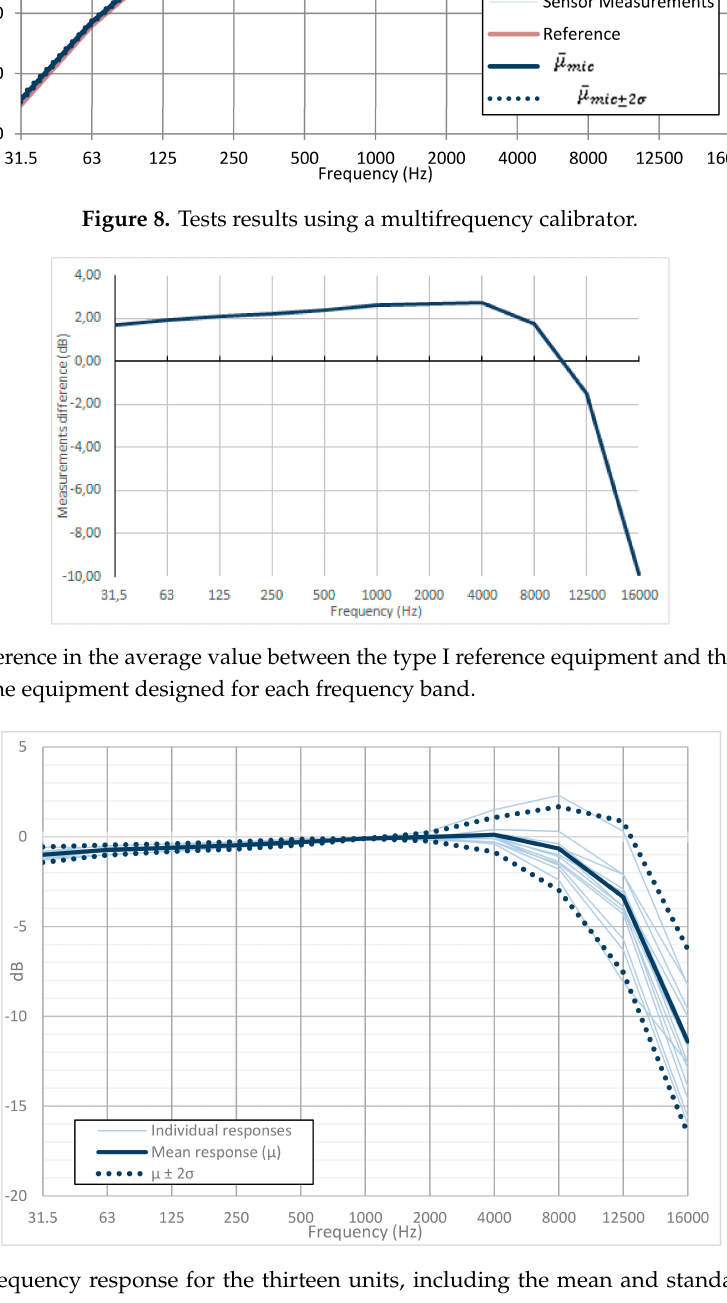
Figure 10. Frequency response for the thirteen units, including the mean and standard deviation for 2 σ